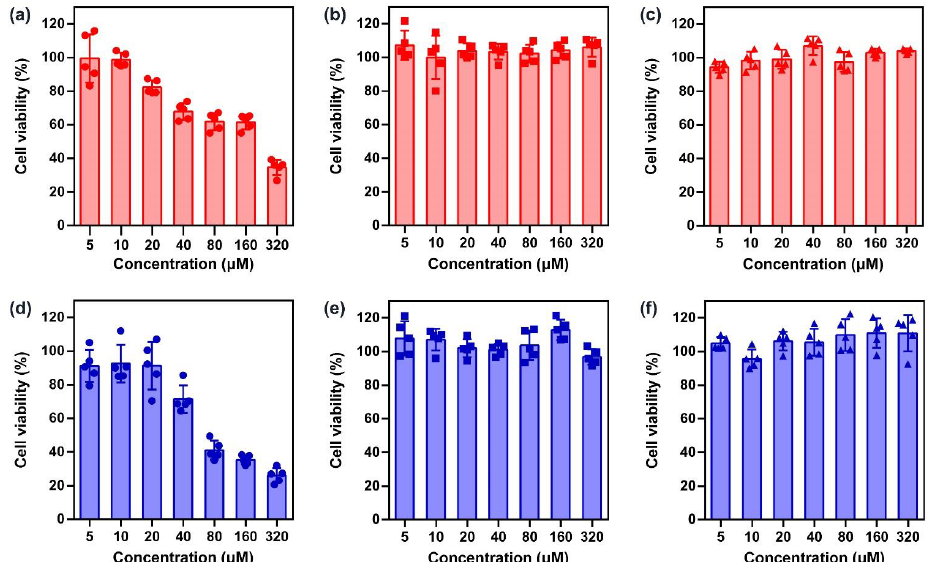
Figure 2. Cell viability of HaCaT cells. After treatment with various concentrations of ( a ) DEP5 ( b ) TEP5 ( c ) QEP5 ( d ) DEP6 ( e ) TEP6 and ( f ) QEP6 for 48 h, the cell viability was determined using a CCK-8 assay ( n = 5, mean ± SD).